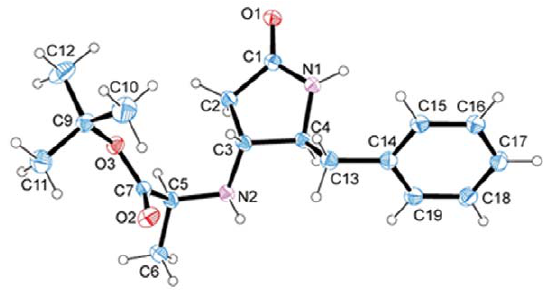
Figure 6. X-Ray molecular structure of 2-pyrrolidinone deriv- ative 4R*,5S*–7b showing the atomic numbering scheme. Thermal ellipsoids are drawn at 50% probability level of non-H atoms, and the H atoms are denoted as spheres of 0.1 A˚